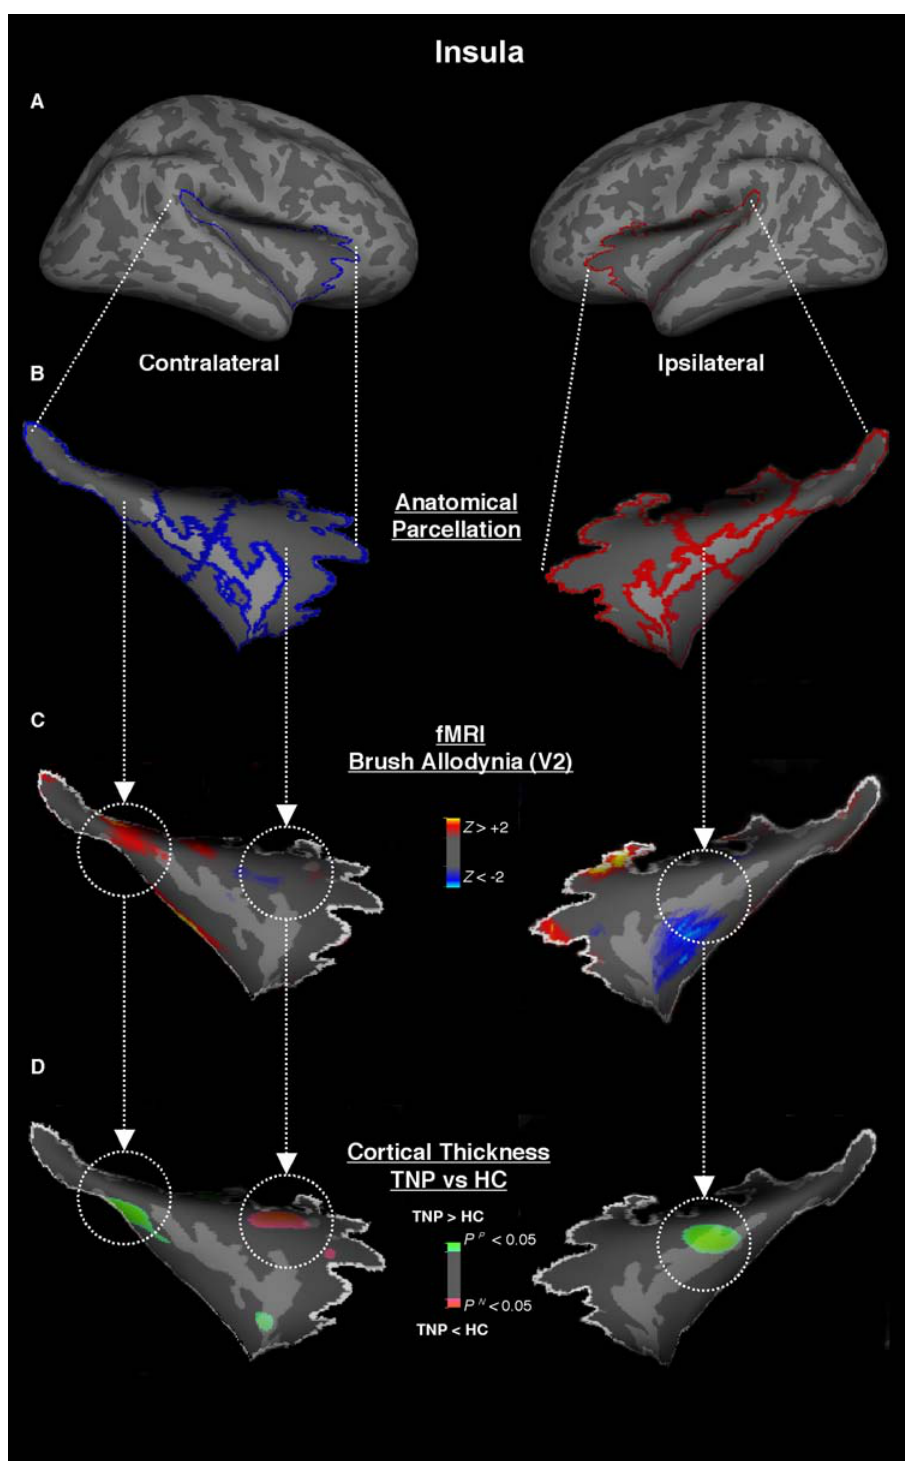
Figure 5. Insula. Panel A and B - The insula was subdivided in seven-parcellated sections along the lateral fissure posterior, insular superior and inferior sulci and the insular gyrus. Panel C - We found contralateral allodynic activation in the posterior insula (lateral fissura posterior) and deactivation in the medial and anterior insula in TNP patients. Panel D – Functional (de)activations were colocalized with cortical thickness changes when comparing TNP and HC groups, with thickening in the posterior and medial insula and thinning in the anterior insula.